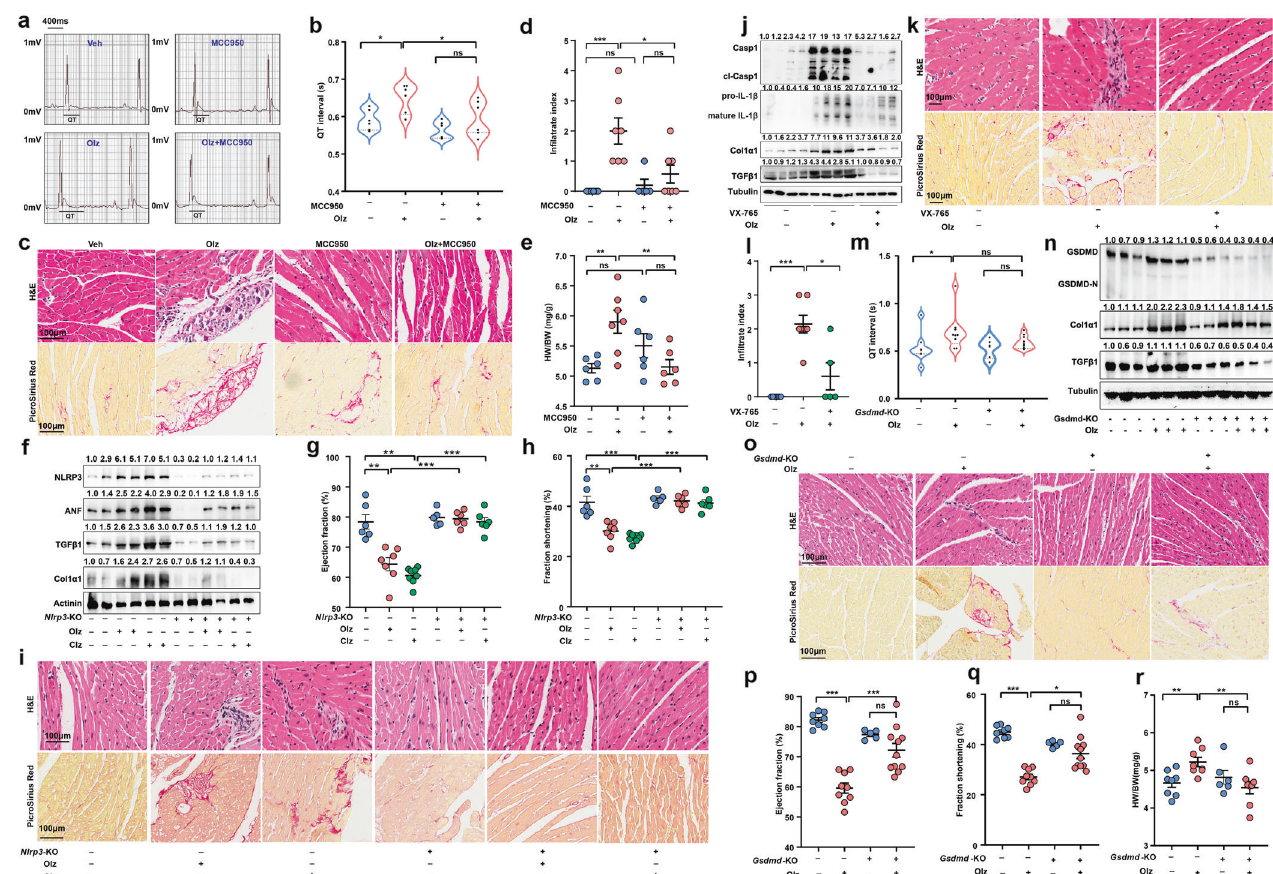
Fig. 2 Genetic knockout or pharmacologic inhibition of cell pyroptosis signi fi cantly alleviated antipsychotic-induced myocardial injuries. a – e Effects of MCC950 (20 mg/kg), a speci fi c NLRP3 inhibitor, on Olz cardiotoxicity ( n = 5 – 7 mice/group). f – i Effects of genetic knockout of Nlrp3 ( Nlrp3 -KO) on AP drugs-induced activation of pyroptosis and cardiotoxicity were assessed ( n = 5 – 8 mice/group). The values above each protein blot ( f ) represent the ratio of protein intensity to actinin. j , k Effects of VX-765 (50mg/kg), a speci fi c Casp1 inhibitor, on Olz cardiotoxicity ( n = 5 mice/group). The values above each protein blot ( j ) represent the ratio of protein intensity to tubulin. l – r Effects of genetic knockout of Gsdmd ( Gsdmd -KO ) on Olz cardiotoxicity ( n = 6 – 9 mice/group). Scale bar = 100 μ m. The values above each protein blot ( n ) represent the ratio of protein intensity to tubulin. All quanti fi cation represents the mean and SEM of each group. Two-way ANOVA was used for all analyses. ns, no signi fi cance. * p < 0.05; ** p < 0.01; *** p <0.001 as